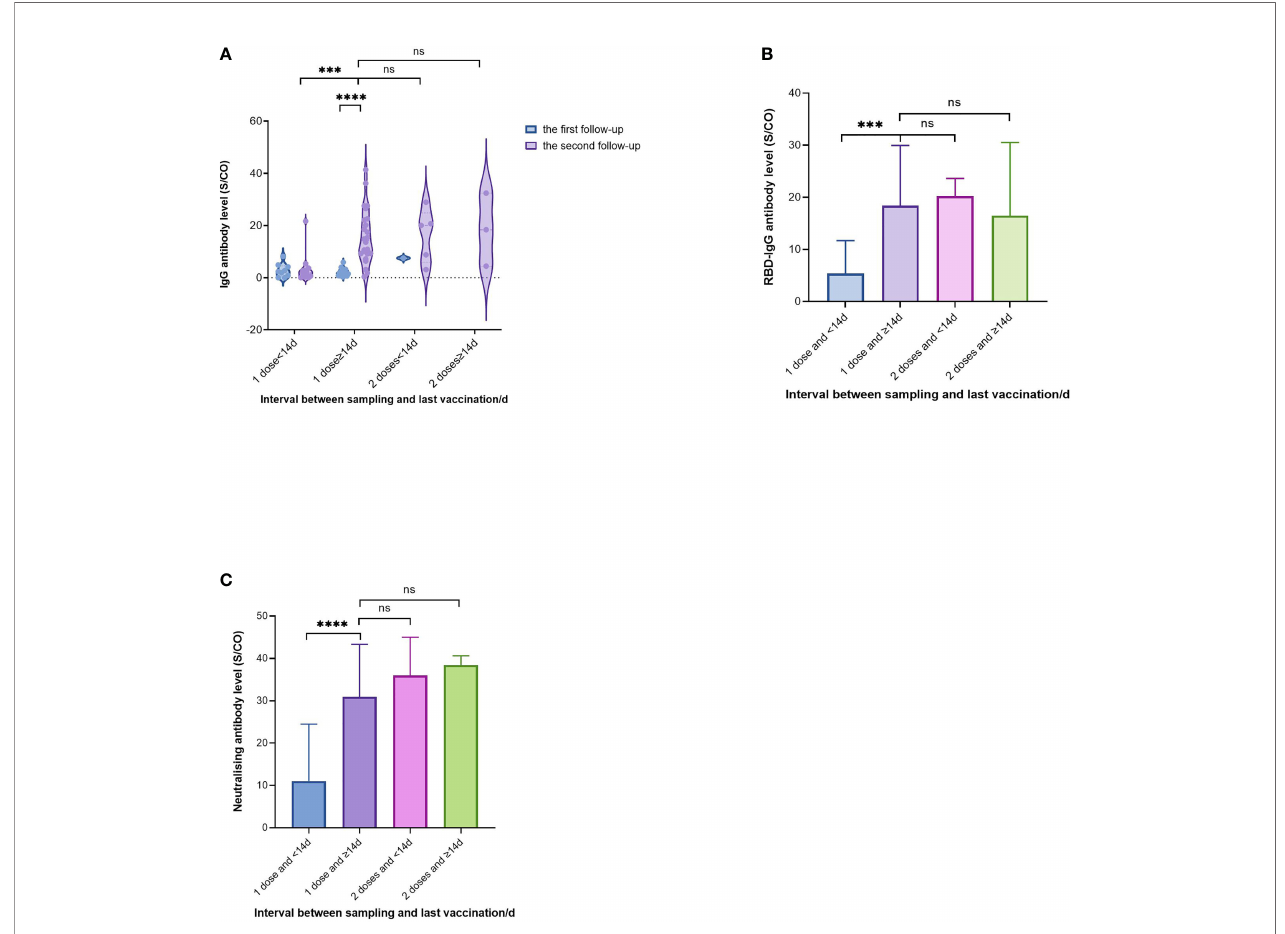
FIGURE 3 | Evaluation of the effectiveness of vaccination on convalescent patients. The participants were divided into 4 parts according to the dose and the inoculation days between the sampling and the last vaccination: “ 1 dose and <14d ” , “ 1 dose and ≥ 14d ” , “ 2 doses and <14d ” and “ 2 dose and ≥ 14d ” . (A) Effect of different doses and inoculation days on IgG antibody levels in two rounds of follow-up. (B) Effect of different doses and inoculation days on RBD-IgG antibody levels. (C) Effect of different doses and inoculation days on neutralising antibody levels. P values were determined applying a two-tailed Mann-Whitney U test. P < 0.05 was considered to be statistically signi fi cant (ns: no signi fi cance; ***p < 0.001; ****p <